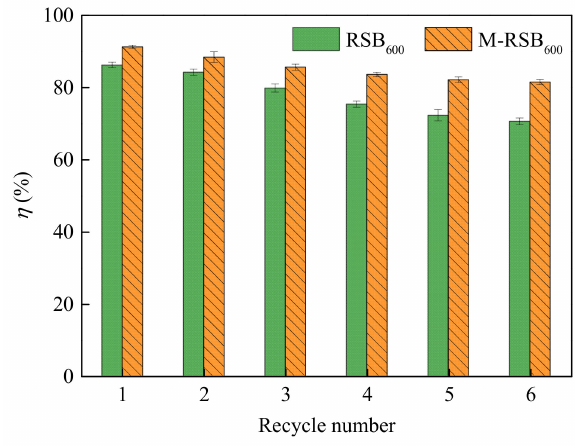
Figure 16. Desorption and regeneration effects of RSB 600 and M-RSB 600 . Table 7. Comparison of MB adsorption capacity by different types of